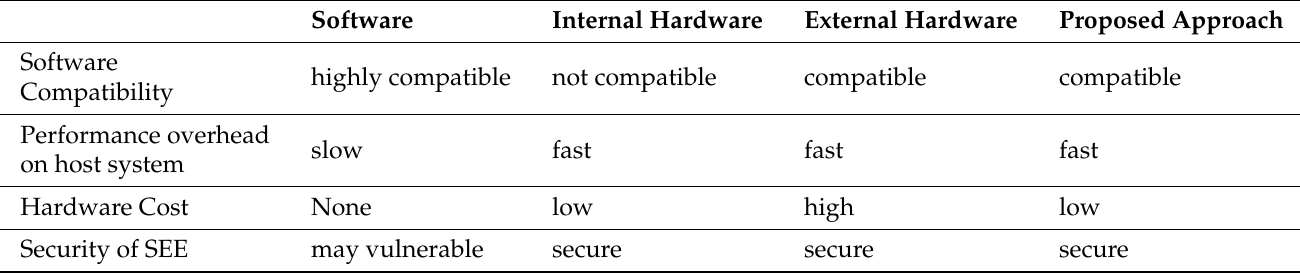
Table 5. Comparison with existing